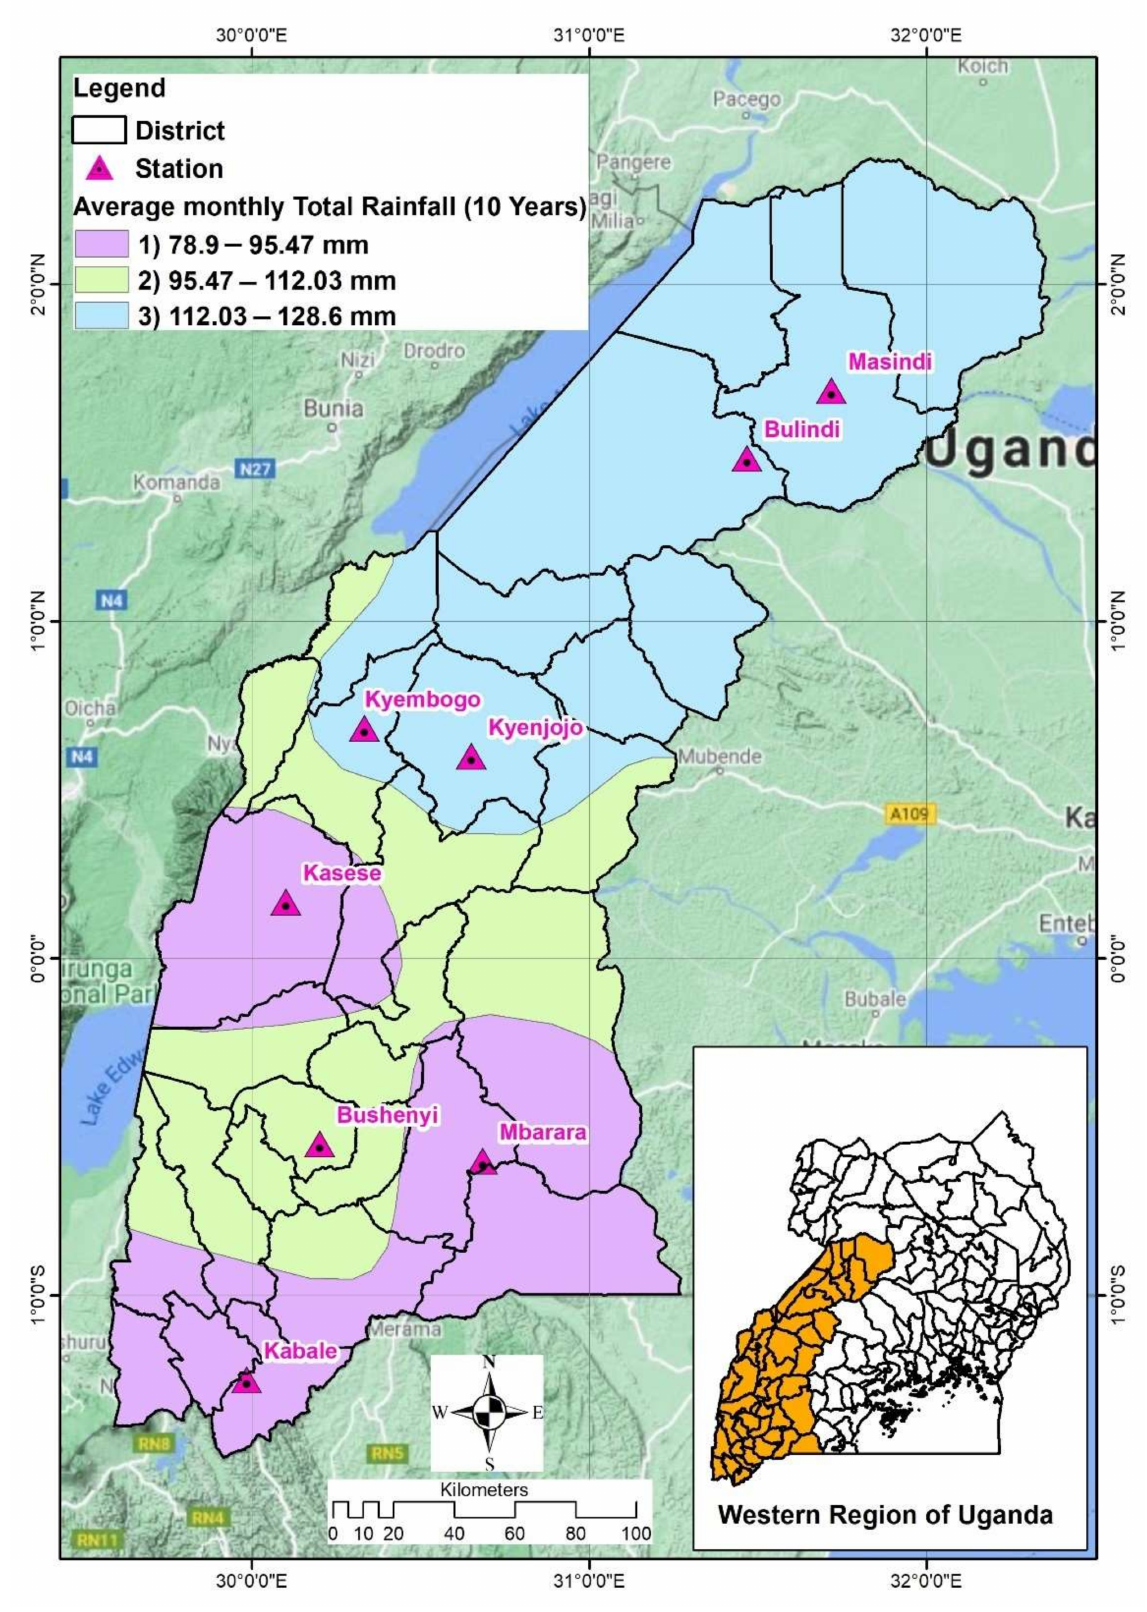
Figure 10. Map showing rainfall distribution in the study